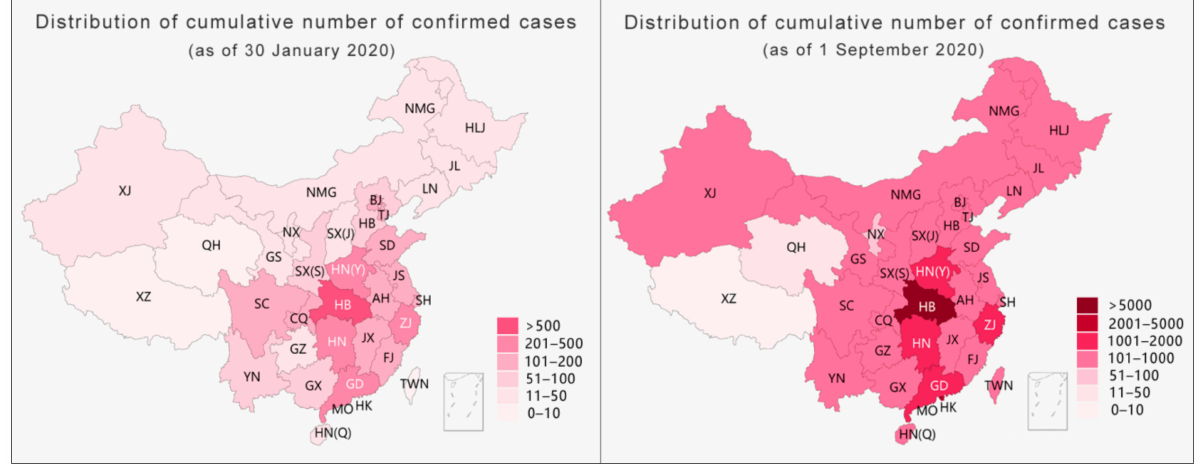
Figure 5. Method of increasing the level of